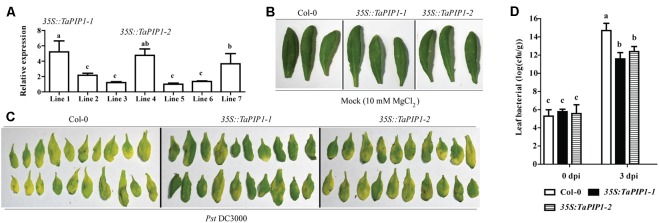
TaPIP1 transgenic Arabidopsis exhibited enhanced resistance to Pst DC3000. (A) qRT-PCR analysis of TaPIP1 transcripts in seven 35S::TaPIP1 transgenic lines. The line 5 with the lowest expression level was set to “1.” Bacterial defense phenotypes on 4-week-old Col-0, 35S::TaPIP1-1, and 35S::TaPIP1-2 plant leaves exposed to 10 mM MgCl2 (mock) (B) and Pst DC3000 (OD600 = 0.002) (C) observed at 3 dpi. (D) The bacterial titre (log10) of Col-0, 35S::TaPIP1-1, and 35S::TaPIP1-2 leaves at 0 and 3 dpi with Pst DC3000 (OD600 = 0.002). Arabidopsis actin2 was used as a reference. Error bars indicate SDs. The data represent the means ± SDs of three independent biological replicates. Different letters in bar graphs indicate significant differences.